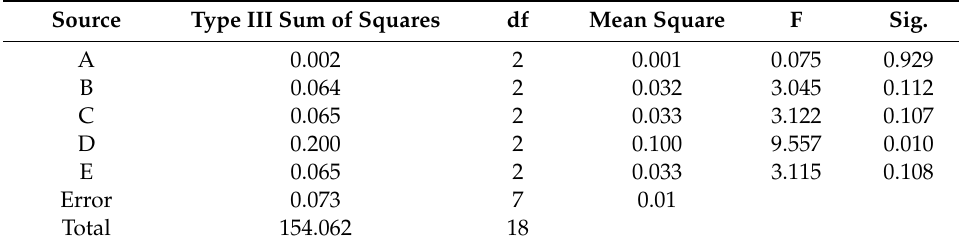
Table 3. Variance analysis of